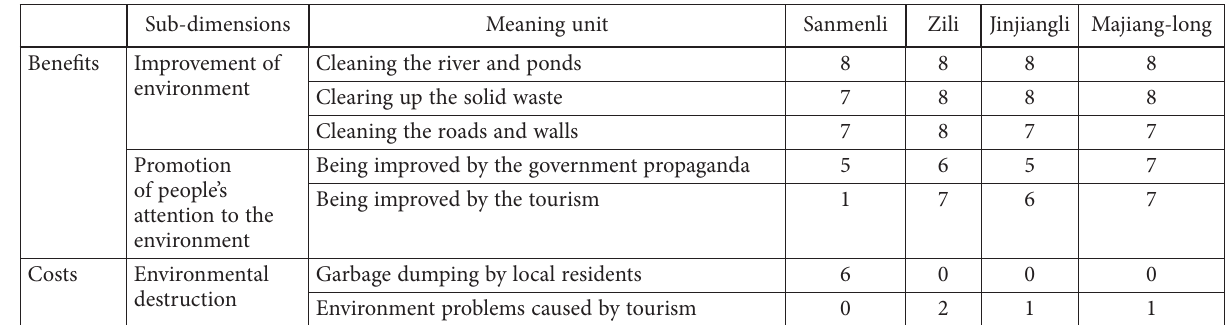
Table 7. Impacts of the WHL inscription from the environmental aspect (source: field survey)